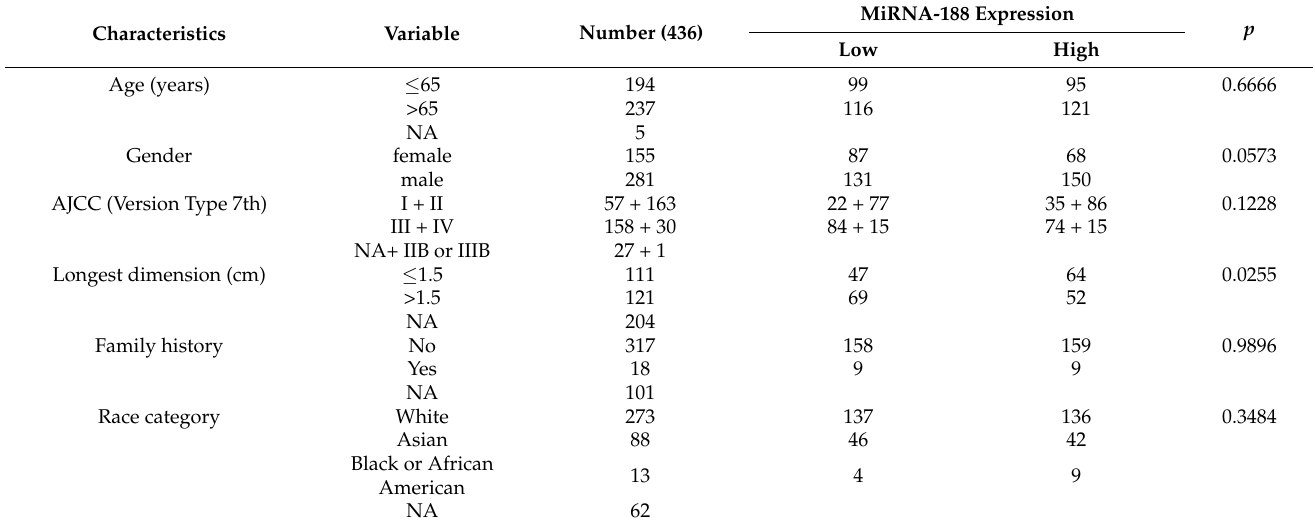
Table 3. Analysis of the correlation between miRNA-188 expression and clinicopathological parame- ters ( χ 2